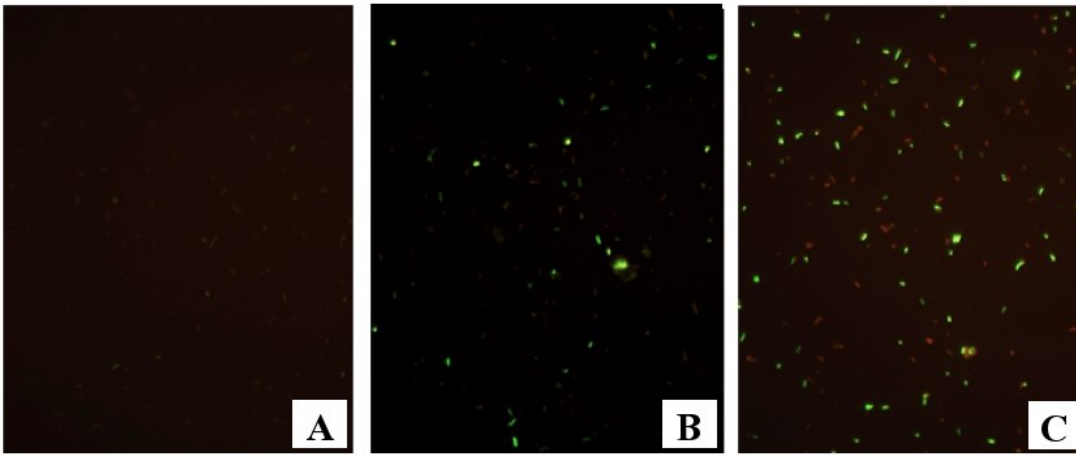
Figure 1. Epifluorescence micrographs of L/D stained samples, where green reflects metabolic activity and red reflects inactivity. ( A ) Untreated fracture water ( B ) CH 4 induced ( C ) CH 4 + SO 42−